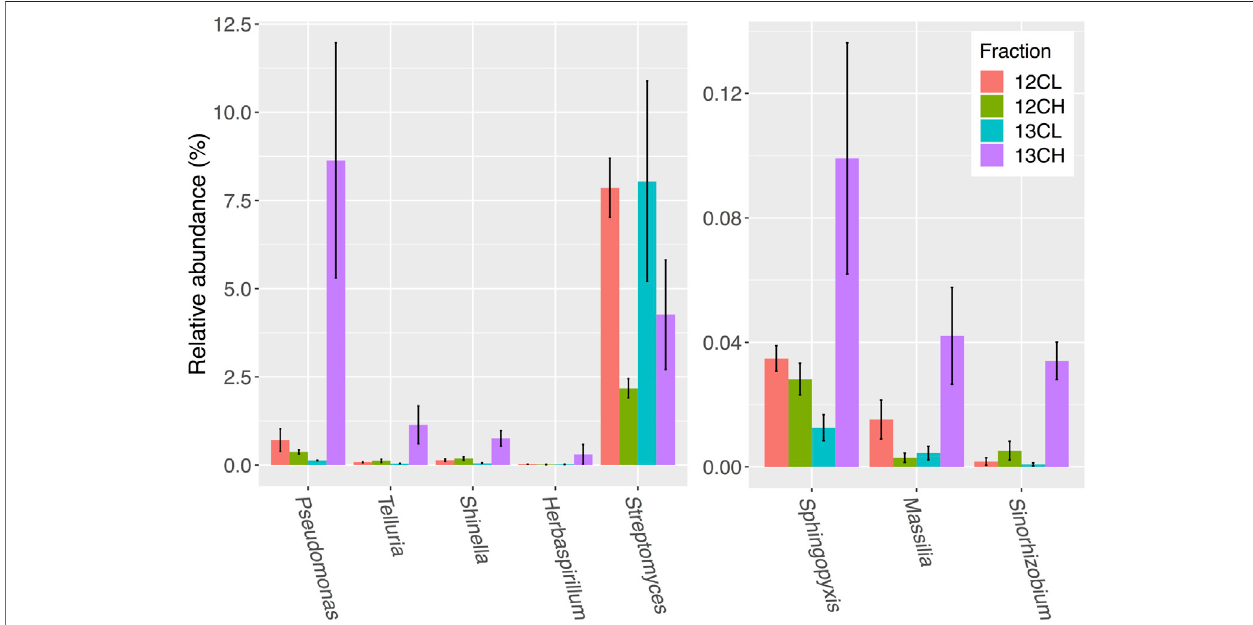
FIGURE5| Sevenbacterialgeneraintherhizospherecompartmentof A.thaliana plantswhoserelativeabundancedemonstratedthegreatestoverallenrichmentin the 13 CH fraction, relative to the 12 CH fraction, due to the metabolism of 13 C labeled root exudates. Streptomyces were not enriched but are included for comparison. 12CL/13CL and 12CH/13CH stand for buoyant density fractions representing the light (L) and heavy (H) fractions of DNA from 12 CO 2 (12C) or 13 CO 2 (13C) incubated plants, respectively. N (cid:2) 3 replicate plants. Bars represent ± SE.